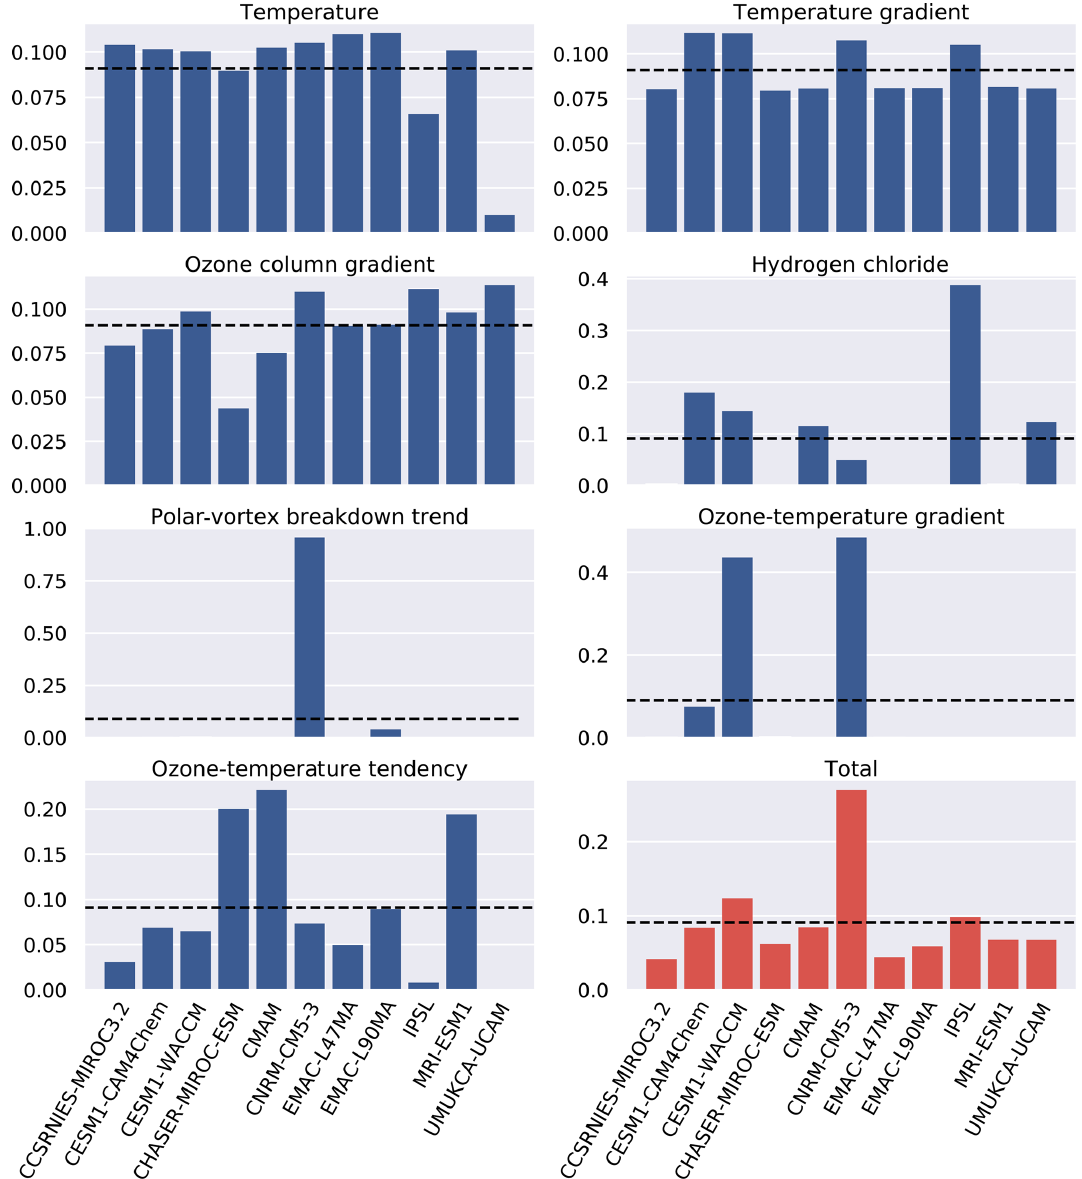
Figure 3. Model weights for each of the seven metrics are all shown in blue. The weights account for both performance and independence and are found using Eq. (1). The total weights, as found from Eq. (2), are shown in red and were the weights used to construct the weighted mean shown in Fig. 2. The black dashed line indicates a uniform weighting as prescribed by a multi-model